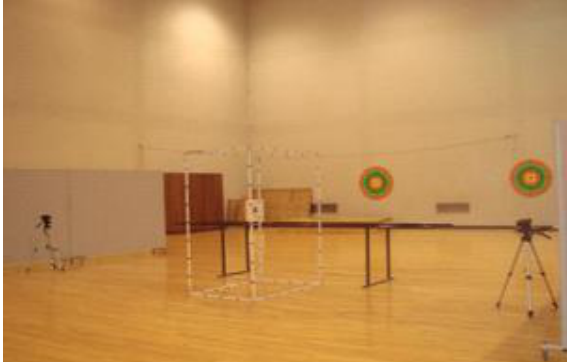
Figure 1. Assembling material for data collection Each dancer was marked in the following anatomical points: ankle joint, knee joint, iliac crest, shoulder joint, elbow joint and wrist joint. After, each dancer performed the different technical skills inside the calibration scale; both cameras captured the images (10 frames per second at 3 megapixel resolution).